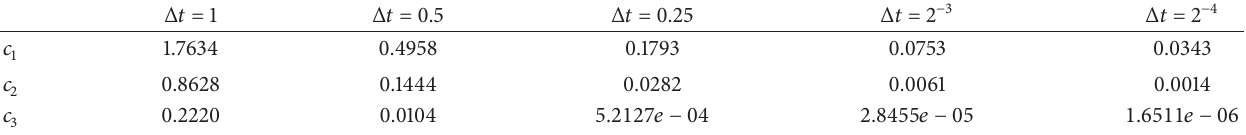
Table 2: Numerical experiment with three iterative steps for the second example and the first component.